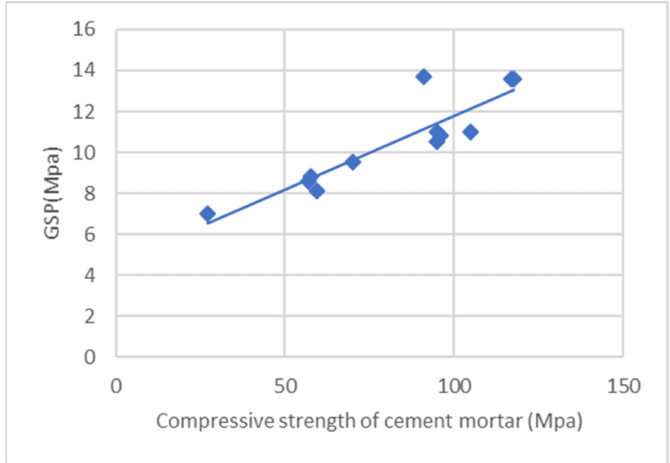
Figure 4. Relationship of compressive strength between cement mortar and GSP